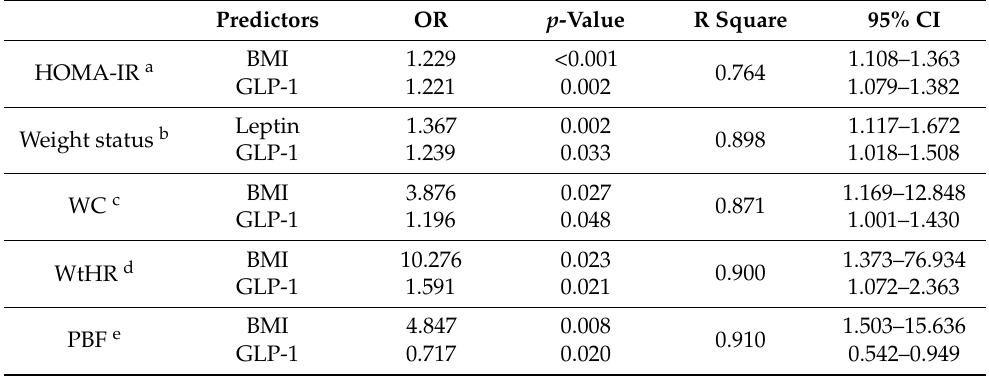
Table 4. Predictors of markers of obesity and